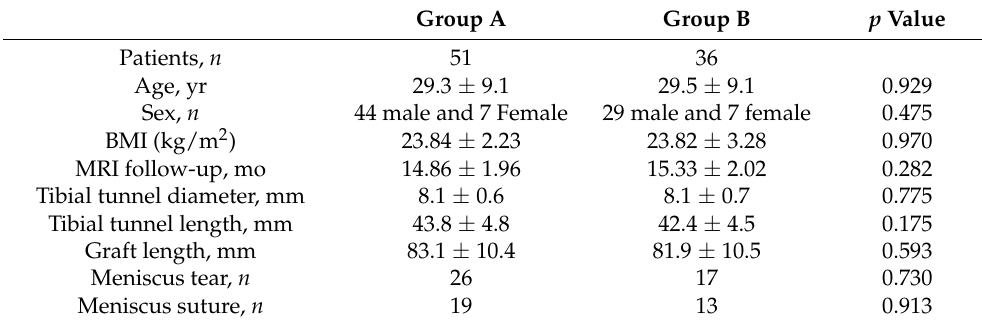
Table 1. Patient Demographic Characteristics.